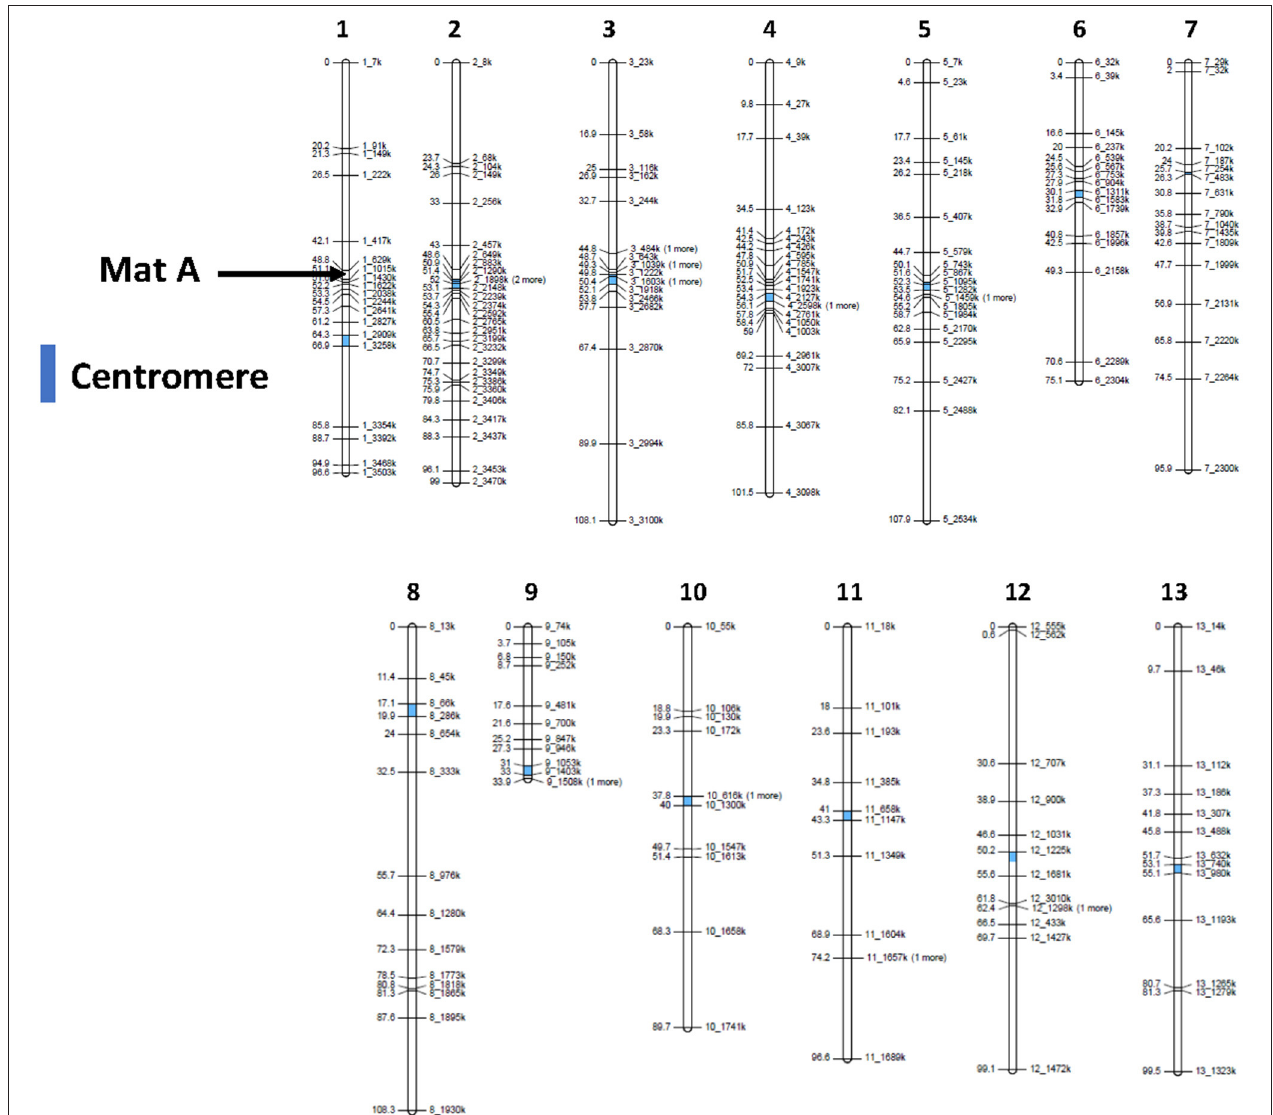
FIGURE 2 | Linkage map generated from an offspring of a cross between H97 (homokaryon of a var. bisporus ) and H119p4 (homokaryon of a var. burnettii ). 180 Homokaryons were genotyped with 215 SNP markers. The position of centromeres (Sonnenberg et al., 2020) are indicated in blue. Map statistics are presented in Supplementary Table 1